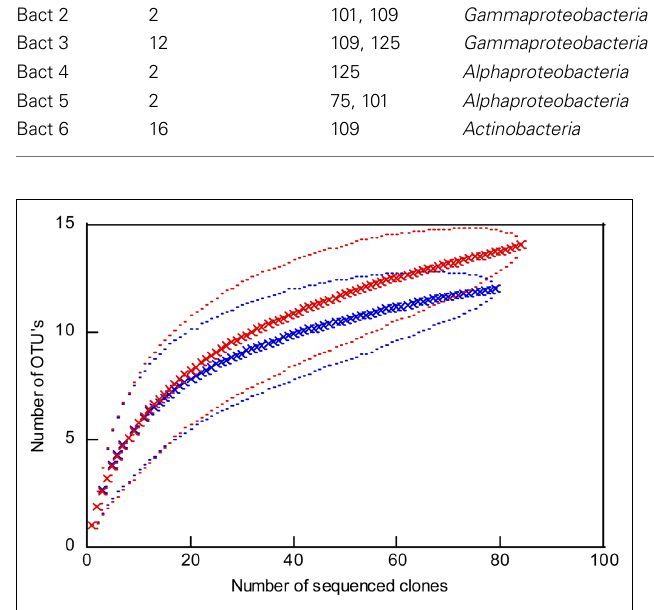
FIGURE 4 | Rarefaction curves for the archaeal 16S rRNA gene sequences from 109m depth (red) to 125m depth (blue). Outer and inner lines: high and low confidence interval (95%). OTU, operational taxonomic unit; cut off of OTU’s =